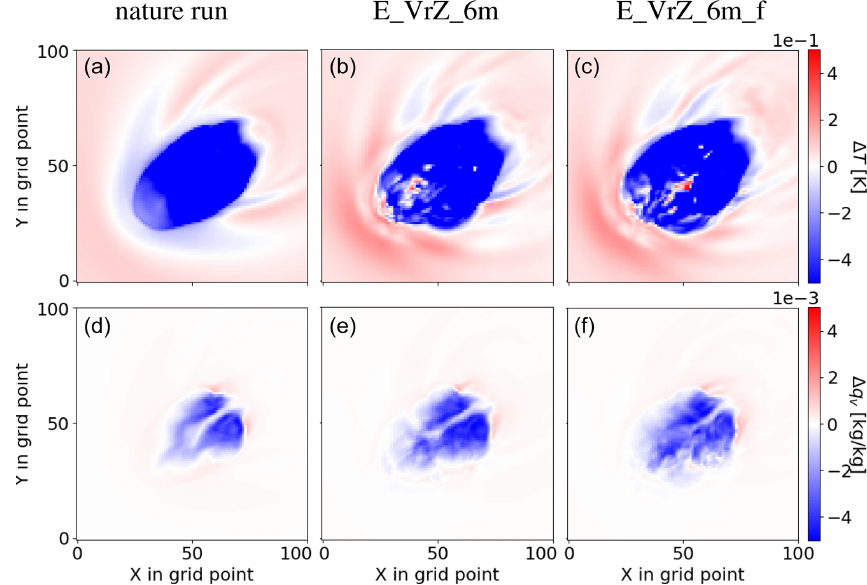
Figure 6. Temperature (a, b, c) and moisture (d, e, f) deviations in the sub-cloud layer for the nature run (a, d) and analyses of E_VrZ_6m (b, e) and E_VrZ_6m_f (c, f) at